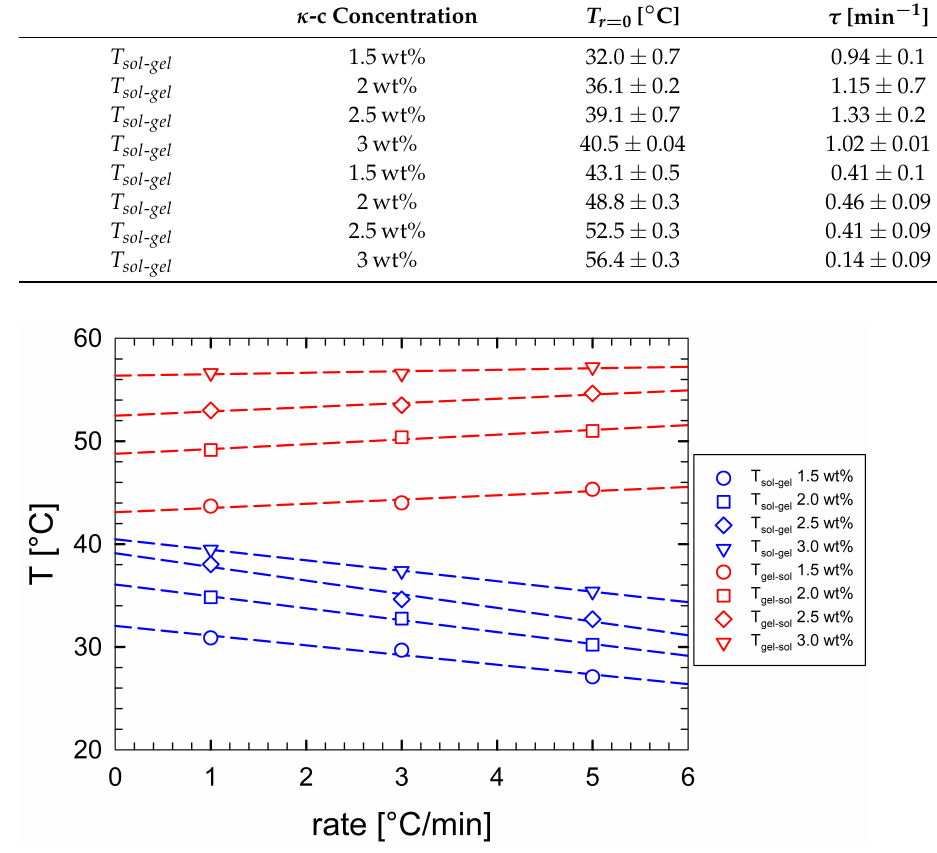
Figure 4. T sol - gel (blue symbols) and T sol - gel (red symbols) as a function of the imposed cool- ing/heating rate for different solutions (see legend for details). Dashed lines are linear regressions.